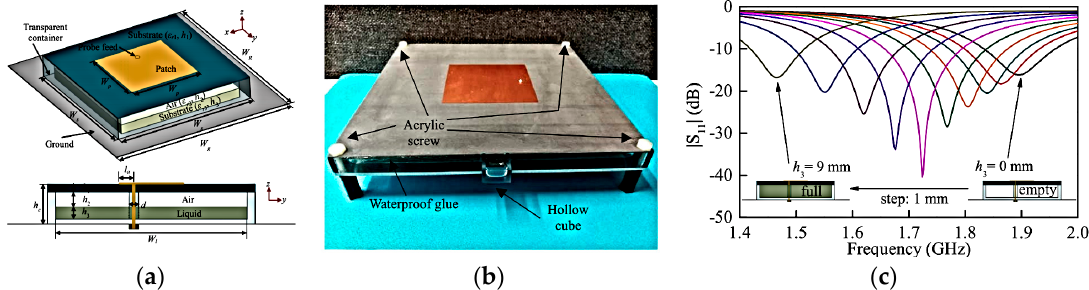
Figure 10. ( a ) Configuration, ( b ) prototype sample and ( c ) frequency response of the reconfigurable antenna (redrawn from [73]).